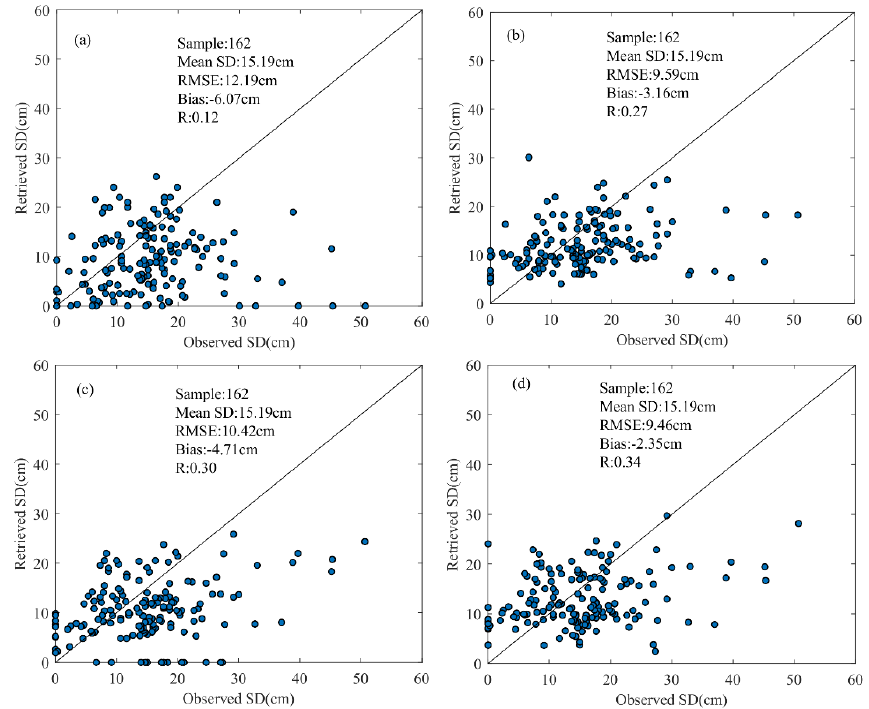
Figure 13. Scatter plots of retrieved SD and observed SD along the snow routes. ( a , c ) represent the raw WESTDC SD product and the FY SD product, respectively. ( b , d ) represent the corresponding downscaling results based on the multifactor SD downscaling model.